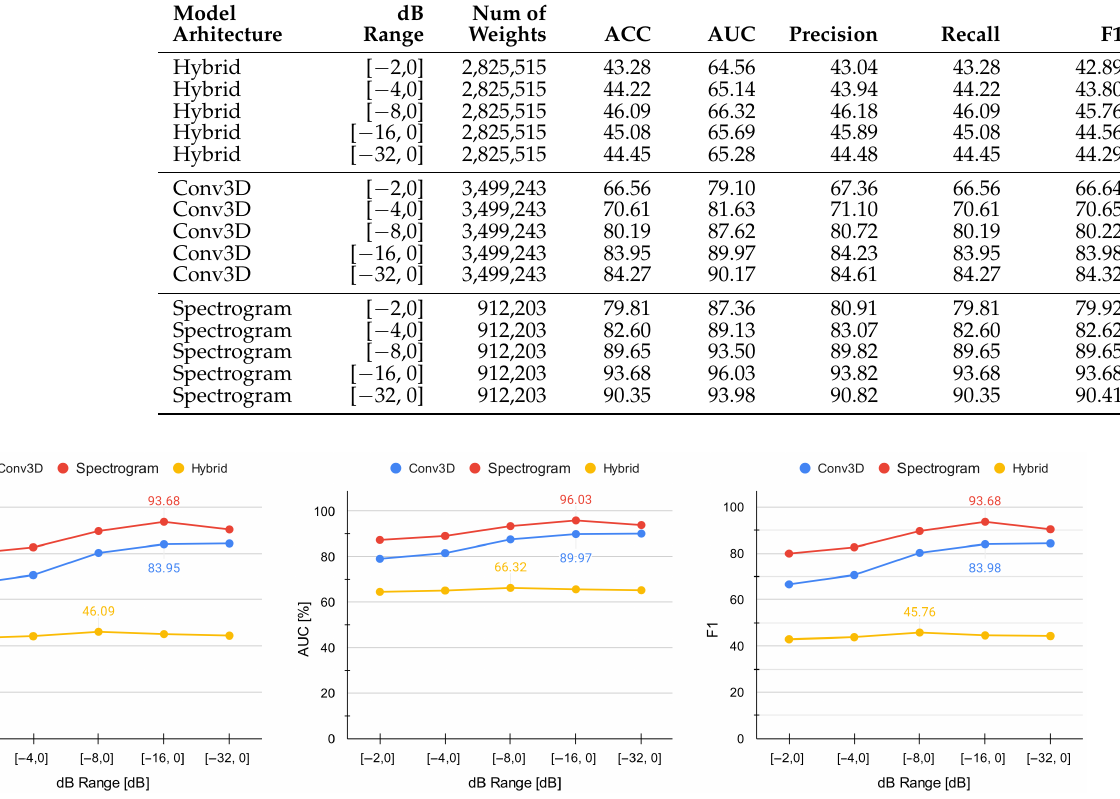
Figure 8. Relationship between accuracy and dB range settings. There is a significant impact of the dB range settings on the performance as long as the model performs reasonably well overall. The optimum for both alternative architectures (Conv3D and spectrogram) is at [ − 16,